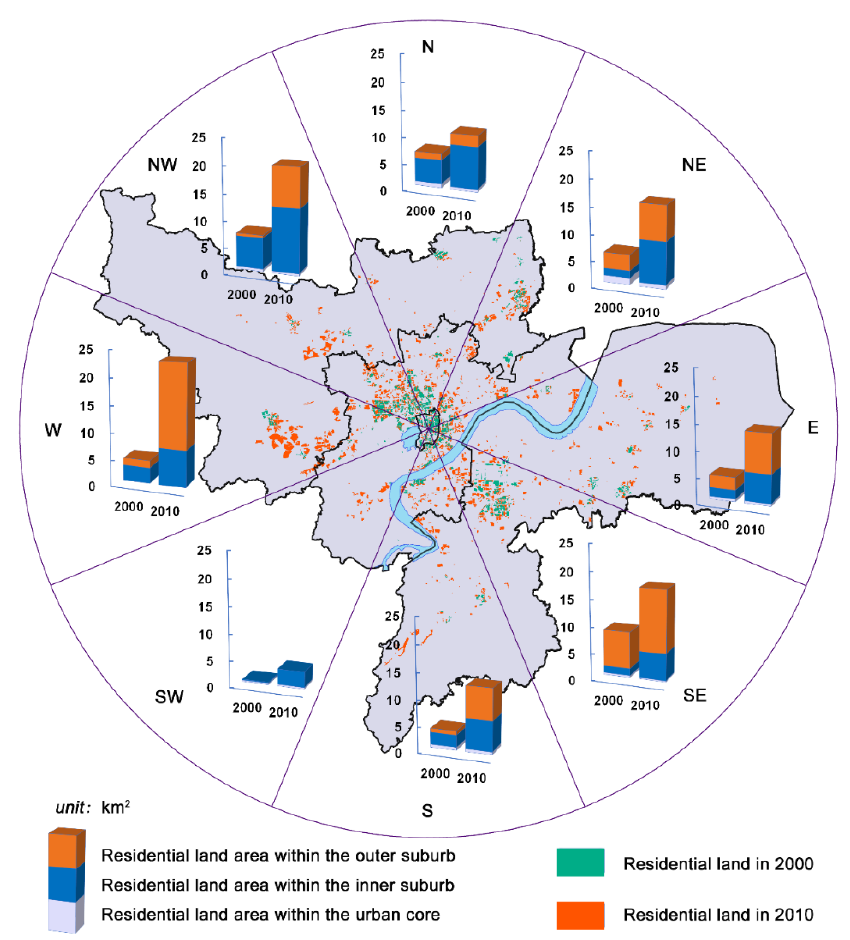
Figure 3. The residential land layout of Hangzhou in 2000 and 2010 (km 2 ).